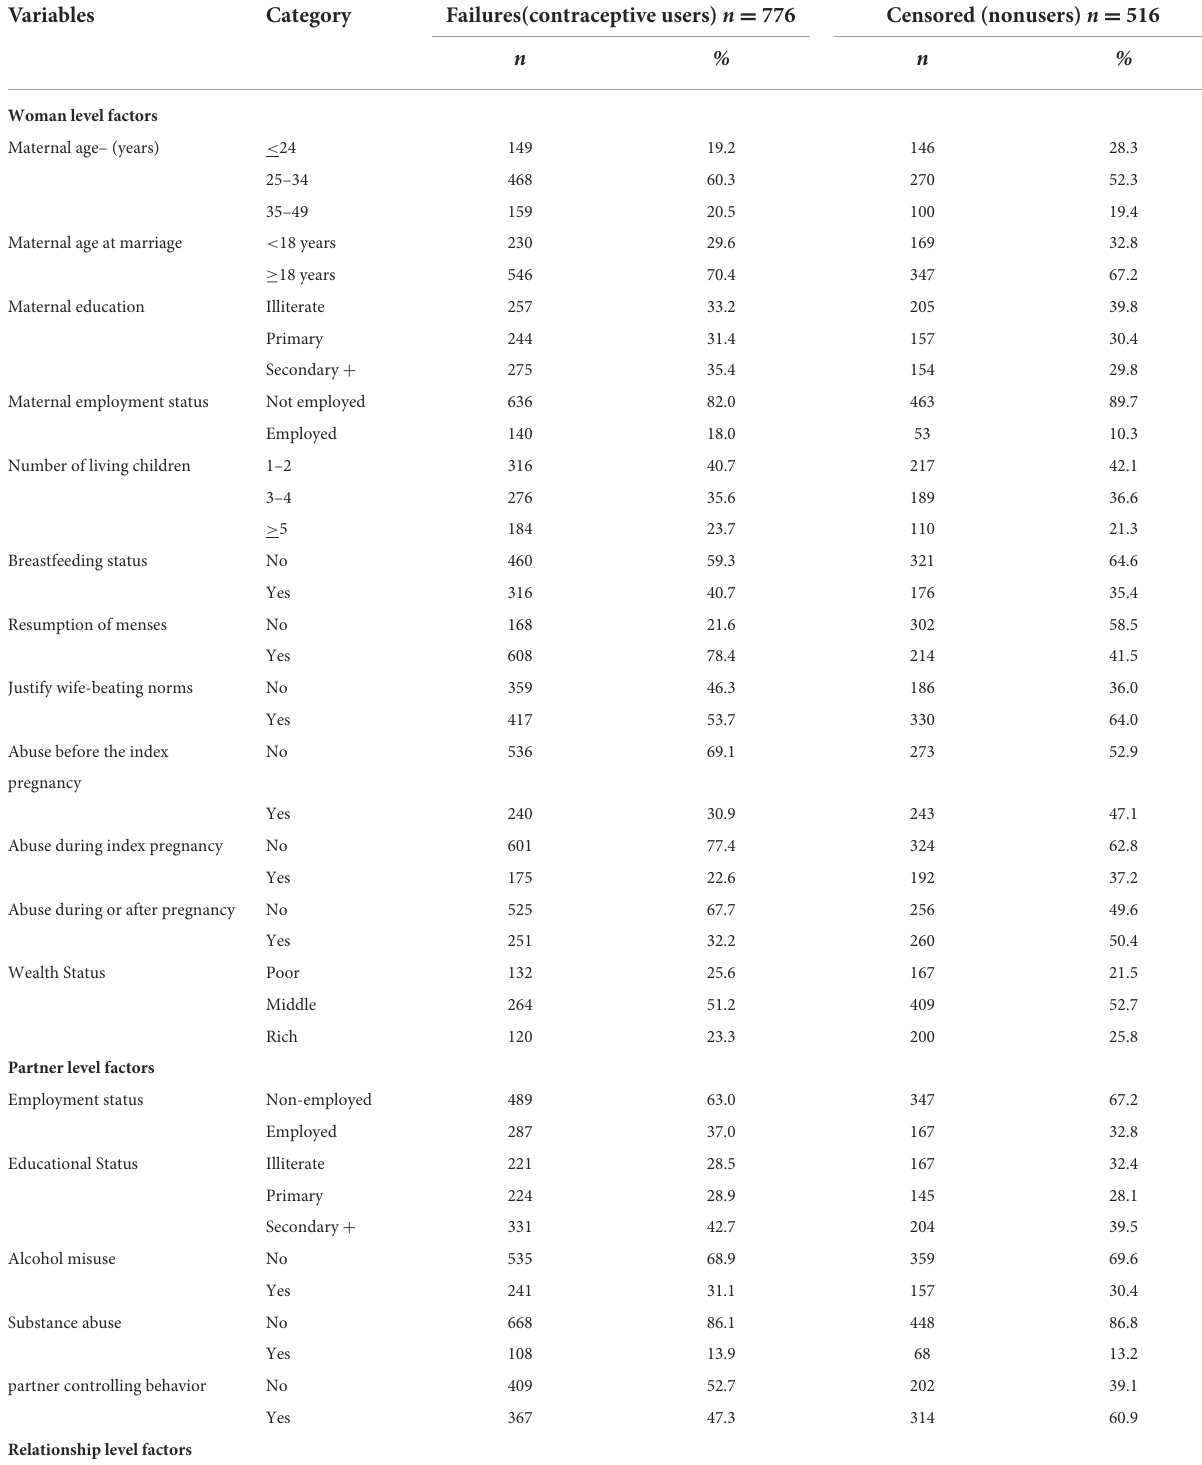
TABLE 1 Individual (women, partner and relationship) and community-level characteristics of study participants ( n = 1292). Survival